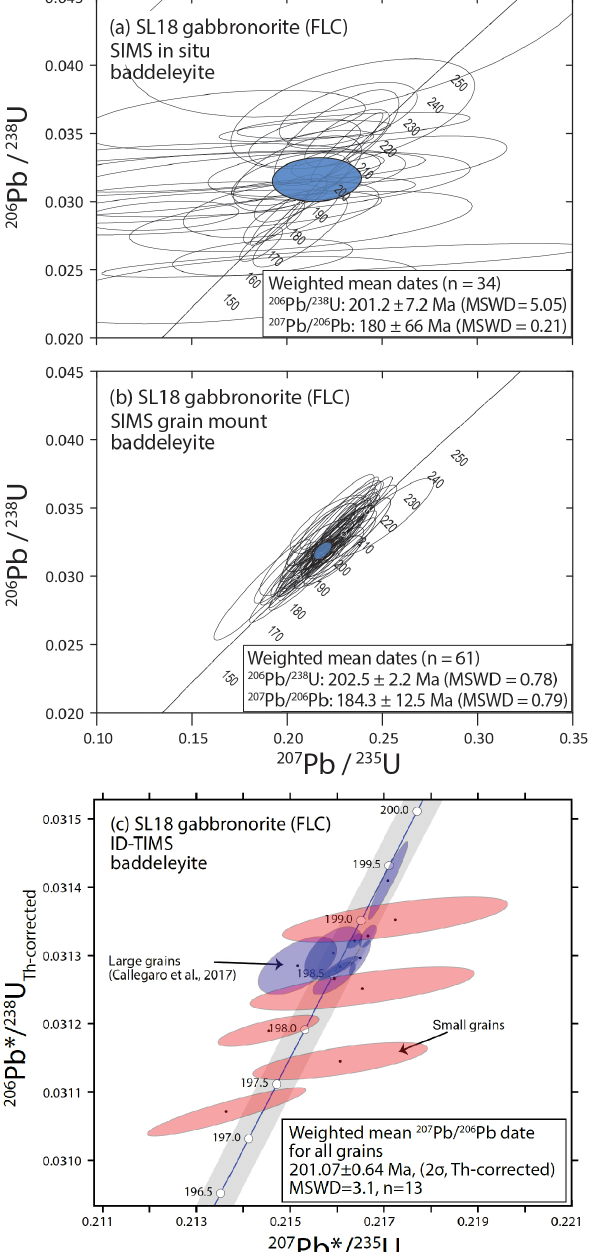
Figure 9. U–Pb baddeleyite data of sample SL18. For the SIMS analyses (a, b) , error ellipses of individual analyses are 1 σ , whereas the weighted mean ellipse (blue) is enlarged to 2 σ . For the ID-TIMS data (c) of large crystals (blue; Data from Callegaro et al., 2017) and small crystals (red; this study), all ellipses represent 2 σ uncertain-